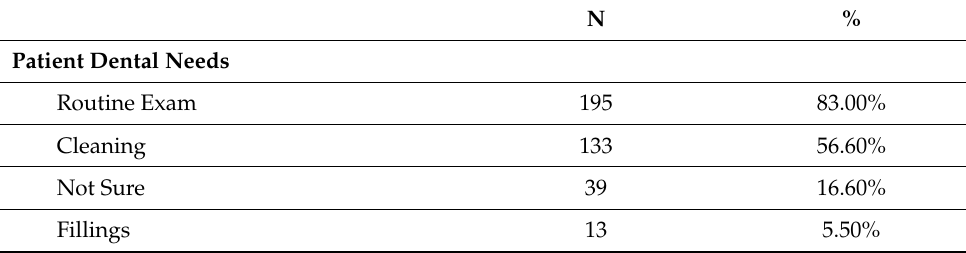
Table 3. Patient dental visit